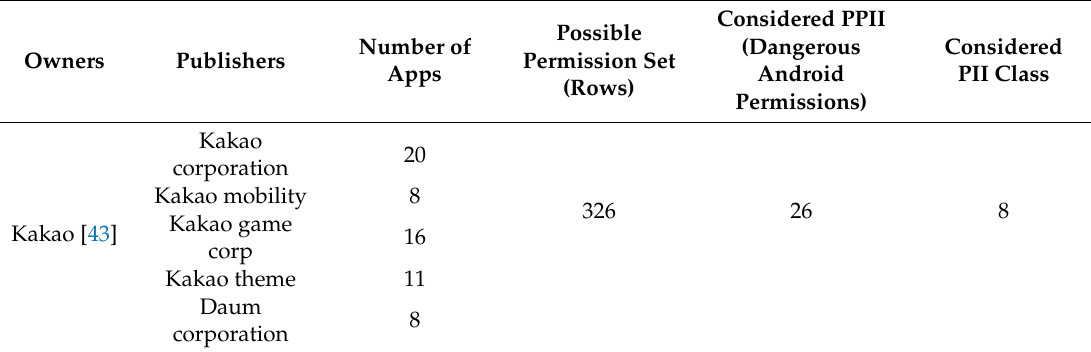
Table 7. Numerical overview of the dataset used for the Kakao case